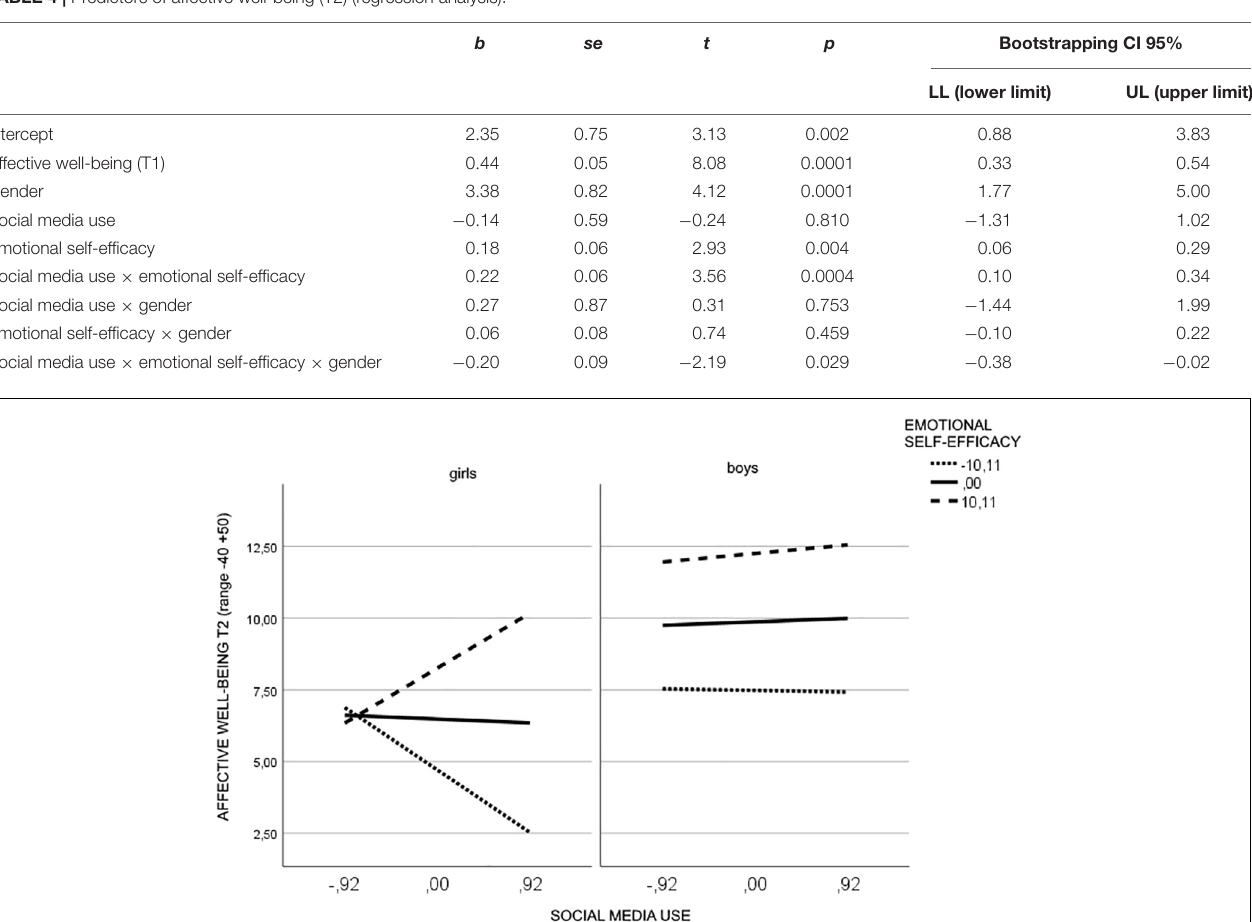
Frontiers in Psychology |